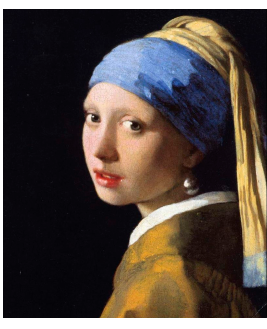
Figure 7. Young girl with a head cover.